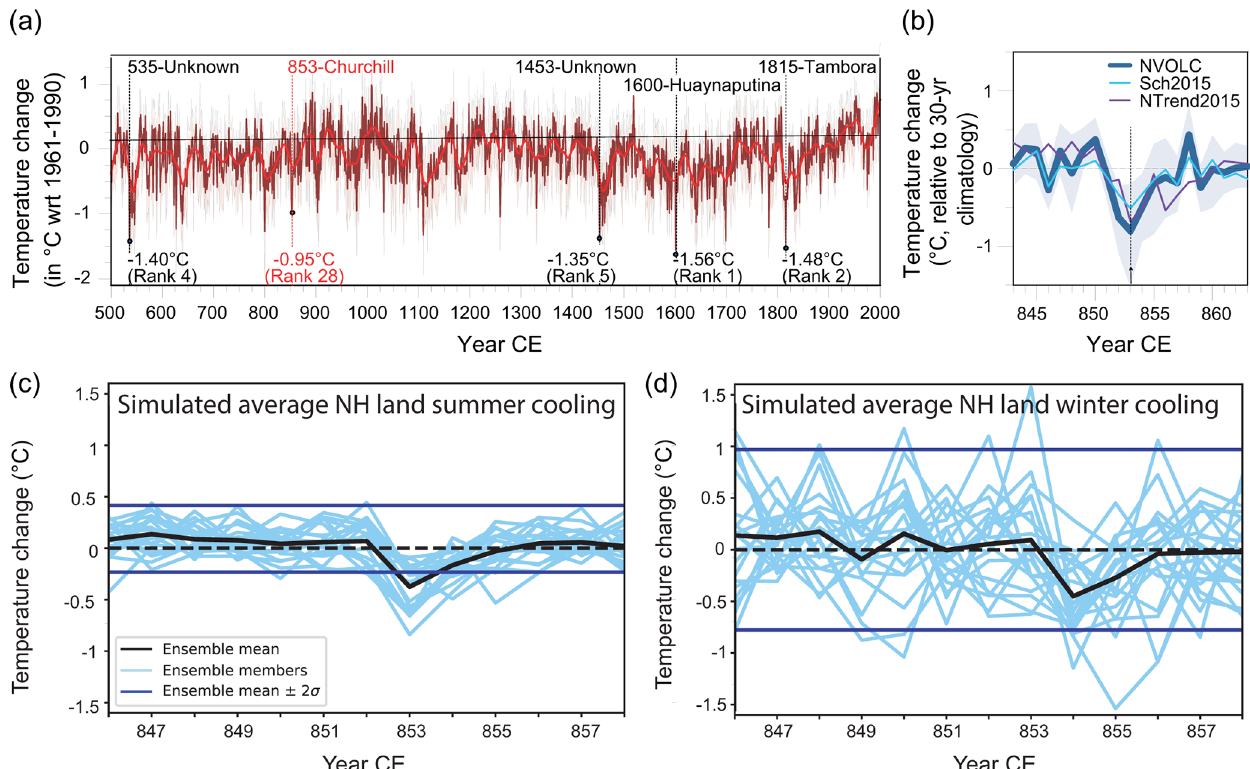
Figure 4. (a, b) Tree-ring-derived temperature reconstructions around the time of the 852/3CE Churchill eruption: (a) unfiltered NH extra- tropical land (40–90 ◦ N) summer temperature anomalies (with respect to the period 1961–1990) since 500CE. The red lines represent the interannual temperature anomaly variations, and the grey lines represent the 95% bootstrap limits. (b) Comparison of the cooling induced by the winter 852/3CE eruption in the NVOLC v2 reconstruction filtered with a 31-year running mean and the Sch2015 (Schneider et al., 2015) and N-TREND2015 (Wilson et al., 2016) NH reconstructions. Grey shaded area represents the uncertainty associated with the NVOLC temperature anomaly reconstruction. (c, d) Simulated NH climate before and after the 852/3 Churchill eruption: 846–858CE time series of spatially averaged NH extratropical (15–90 ◦ N latitudes) land temperature anomalies from 20 ensemble simulations for (c) summer (JJA) and (d) winter (DJF) in light blue lines. The thick black lines indicate the ensemble means, and the horizontal blue lines represent 2 standard deviations from the ensemble means of the 845–852CE pre-eruption period. For comparative purposes, the 1961–1990 reference period used for the tree-ring reconstructions (a, b) was 0.1 ◦ C warmer than the modelled climate simulation reference period (c, d) of